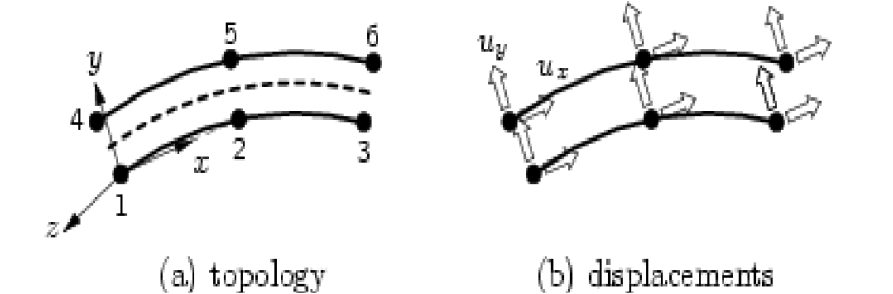
Fig. 6. Shcematic of Line interface elements for connecting beam element to solid